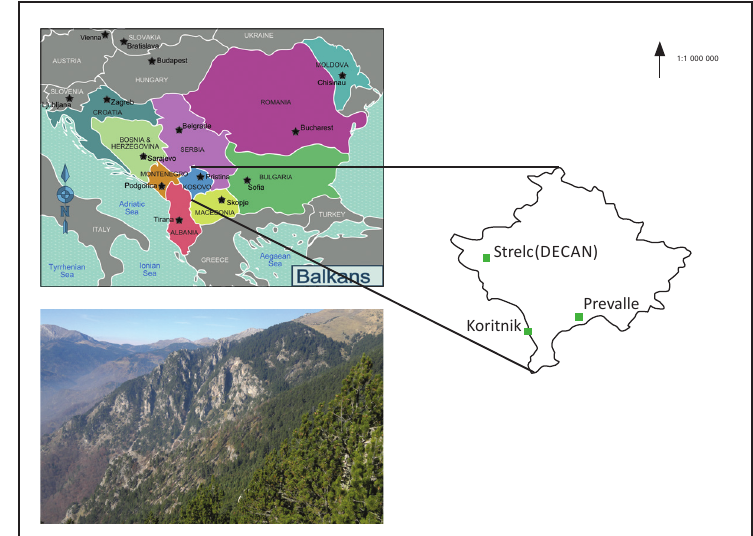
figURe 1. The location of Kosovo (upper left side) in Europe and of the sampled sites (right